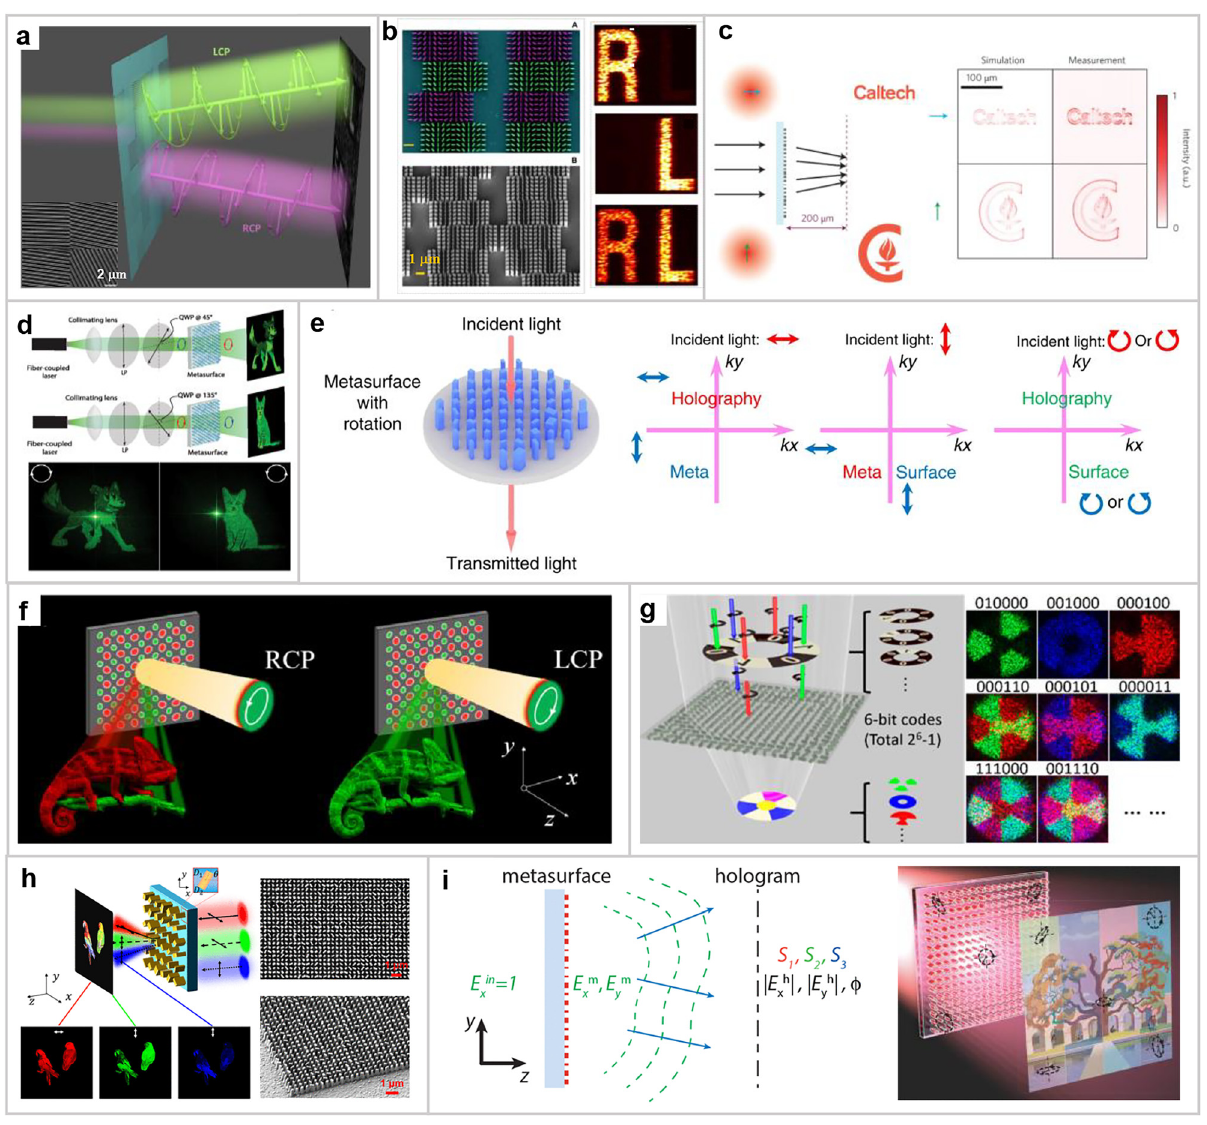
Figure6: Applicationsofpolarizationmanipulationinmeta-hologramswithall-dielectricmetasurfaces.(a)Ameta-hologramsobtainedbyleft and right circularly polarized illumination and the corresponding simulated results [107]. (b) Chirality-dependent phase meta-holograms that project different images depending on the chirality of the incident beam with interleaved meta-atoms design [108]. (c) A polarization- switchable dielectric metasurface that generates two holograms under the illumination of x - and y -polarized light [67]. (d) A TiO 2 metasurface whichcanachieveindependentandarbitraryphasepro fi lesonanypairoforthogonalstatesofpolarizationforfullyindependenthologramsof a “ cartoon dog ” and a “ cartoon cat ” [109]. (e) Multi-channel holography by exploring birefringent Si metasurfaces for the complete control of polarizationandphase[110].(f)Schematicillustrationofthepolarization-controlledinterleavedmetasurfacewithdifferentcolordistributions for RCP and LCP incident polarizations [111]. (g) A multiplexing metasurface with non-interleaved single-size Si nano fi ns arrays with 6-bit polarization- and wavelength-dependent encoded color holograms [112]. (h) A tri-polarization-channel non-interleaved TiO 2 metasurface for far- fi eld color holography with almost zero crosstalk [113]. (i) A vectorial full color hologram with Si metasurface by assigning the red-green- blue data in arbitrary color images to three Stokes parameters [114]. Reprint permission obtained from [67, 107 –